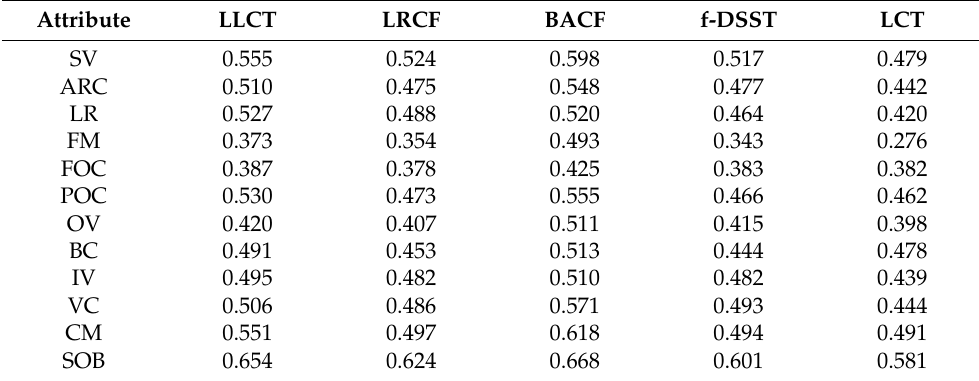
Table 2. The average precision on UAV123.